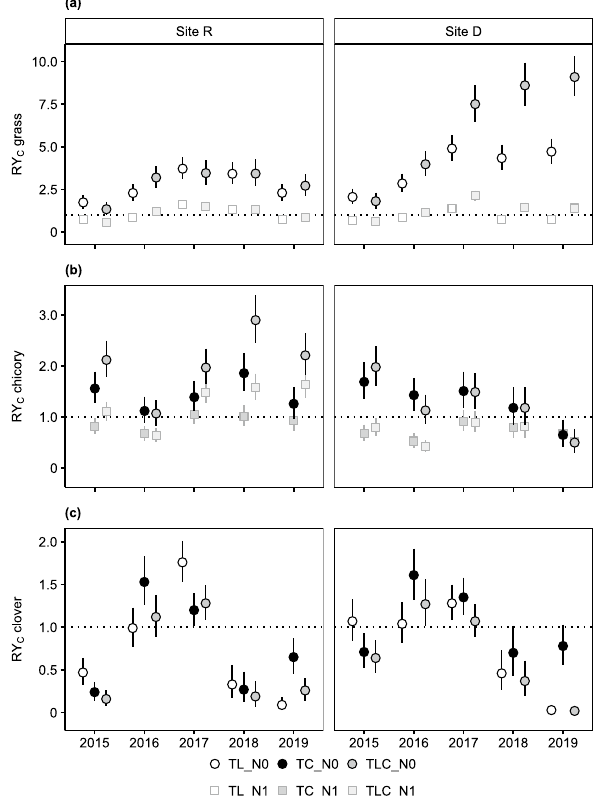
Figure 4. Temporal trends of corrected relative yields (RY C ) of ( a ) grass, ( b ) chicory and ( c ) clover for different mixture types (TL: clover-grass mixture, TC: clover-chicory mixture, TLC: clover-grass-chicory mixture) at both study sites (site R, site D) using either unfertilized (N0) or fertilized (N1) non-leguminous pure stands as a reference. Given values are model predictions with 95% confidence intervals ( n = 64). Note that scales of the y-axis differ between panels. Pure stand and mixture yield of grass, chicory and clover can be found in Supplementary Table